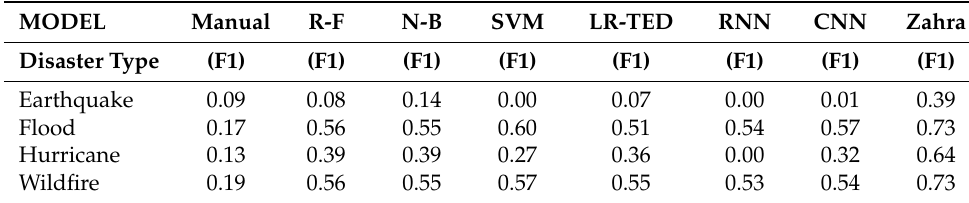
Table 12. Comparison of Results—Eyewitness (All Experiments). MODEL Manual Disaster Type Earthquake Flood Wildfire Table 13. Comparison of Results—Non-Eyewitness (All Experiments). MODEL Manual Disaster Type Earthquake Flood 0.40 Hurricane Wildfire Table 14. Comparison of Results—Unknown (All Experiments). MODEL Manual Disaster Type Earthquake